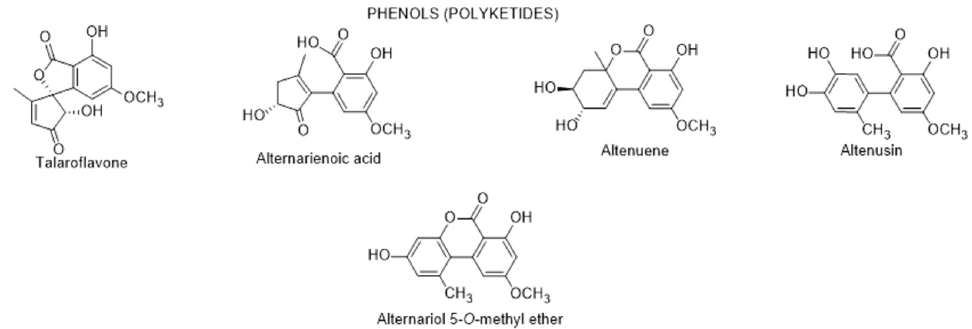
Figure 6. Metabolites isolated from the endophytic Alternaria sp. isolated from the leaves of L. schweinfurthii. Table 2. Biological properties found for some compounds isolated from endophytic fungi found in L. schweinfurthii and L. intricatum (adapted from [89,91–93].